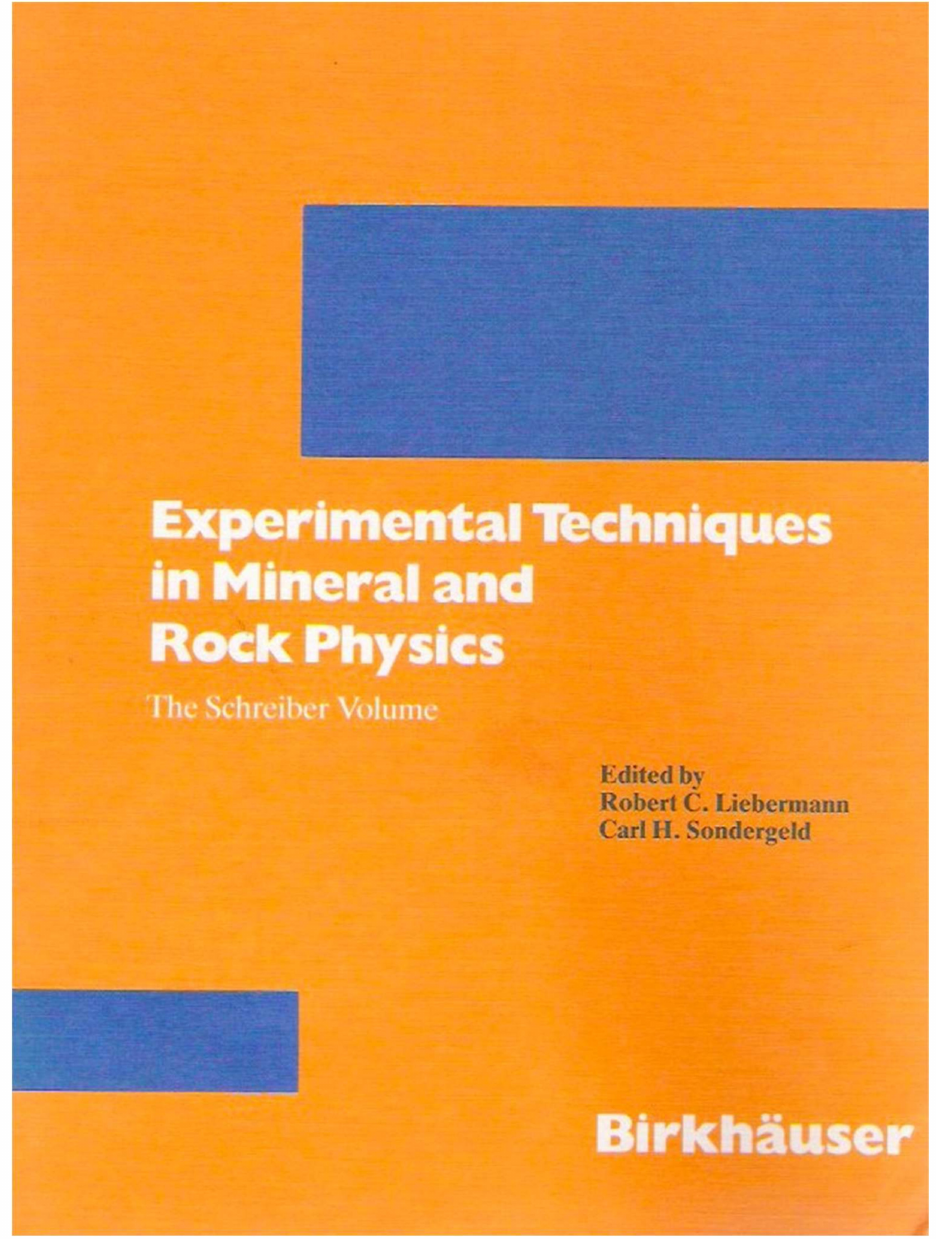
Figure 4. The Schreiber Volume edited by Liebermann and Sondergeld